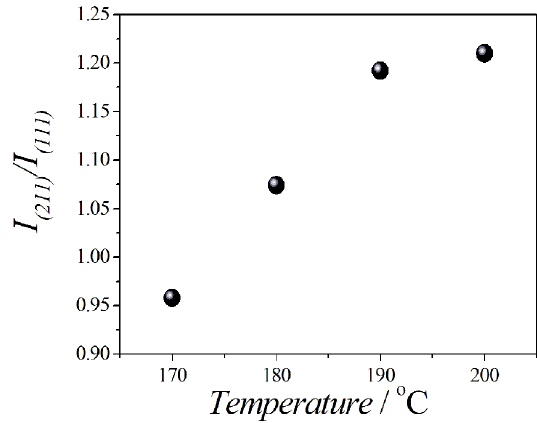
synthesized at 170 ºC, 180 ºC, 4